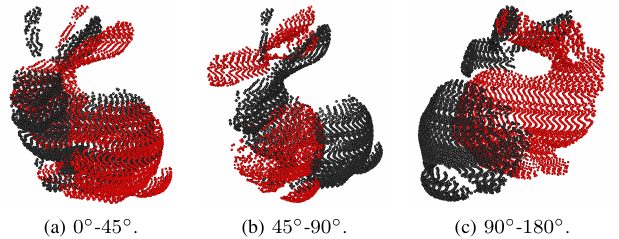
Fig. 3: The three alignment cases tested in the first